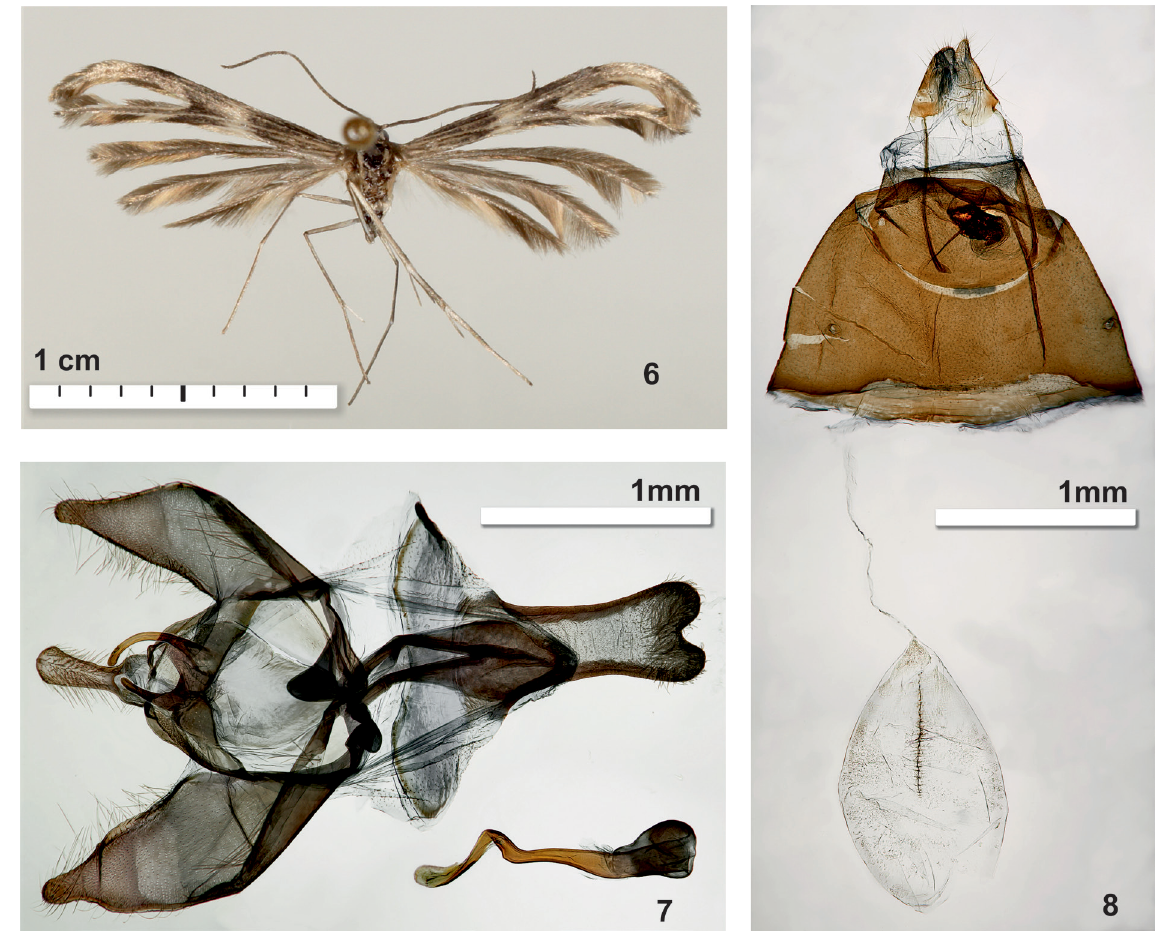
Figs 6–8. Singularia guajiro Kovtunovich & Ustjuzhanin sp. nov. 6 . Holotype (ZISP 1842). 7 . Holotype, genitalia (ZISP 1842). 8 . Paratype, ♀, genitalia (ZISP